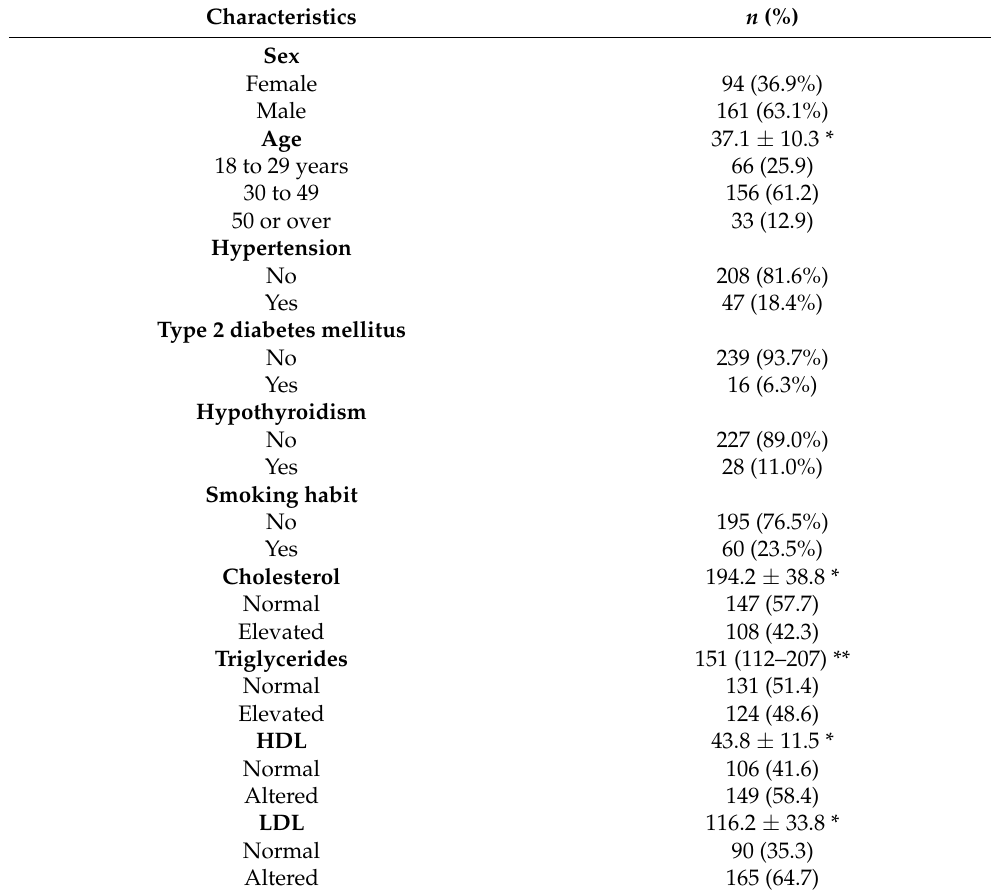
Table 1. Demographic characteristics, medical history, and laboratory and clinical markers of the study sample ( n =